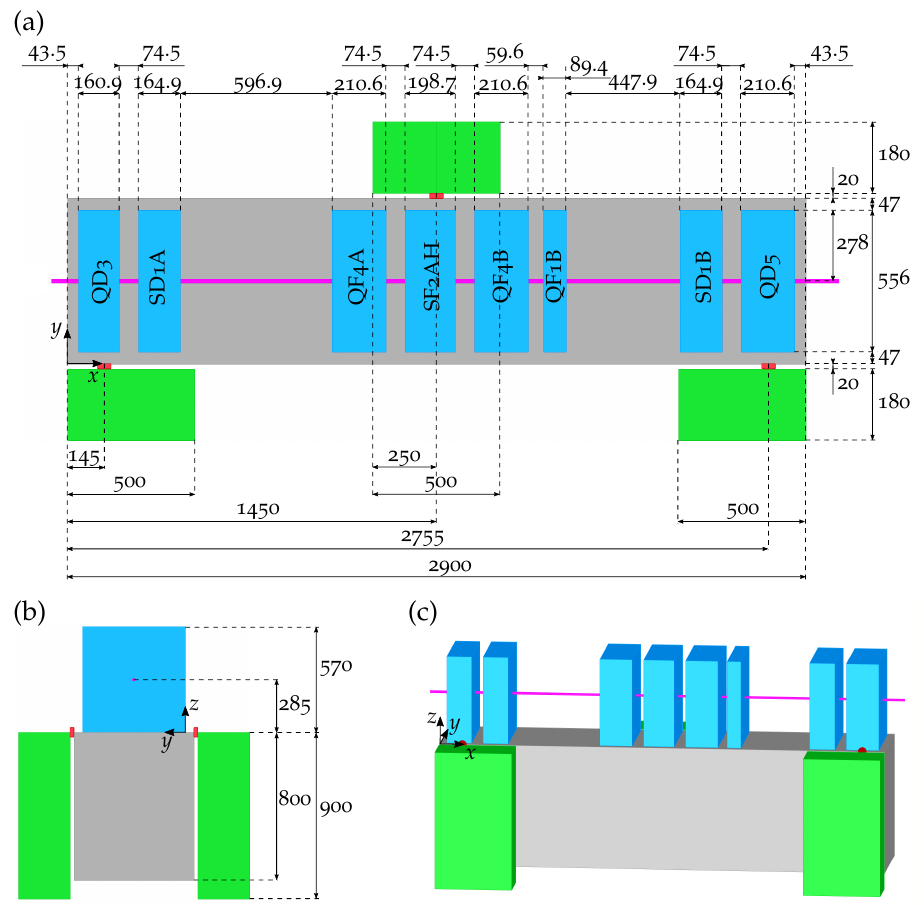
Figure 6. Top view ( a ), side view ( b ), and 3D view ( c ) of the general model of the 3 m PETRA IV magnet–girder assembly including the girder design space (grey), the three bases (green), the eight magnets (blue), and the three beams connecting the girder to the bases (red). The location of the particle beam is shown in magenta. All given dimensions are in